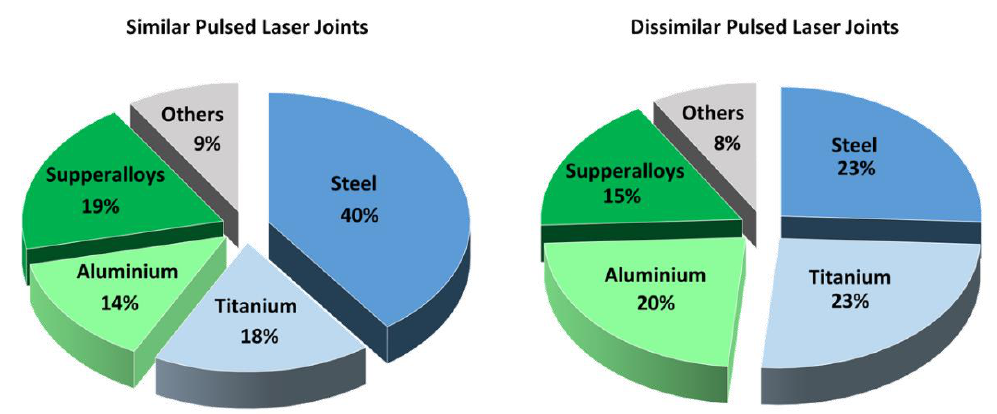
Figure 6. Material division of the pulsed laser welding articles.